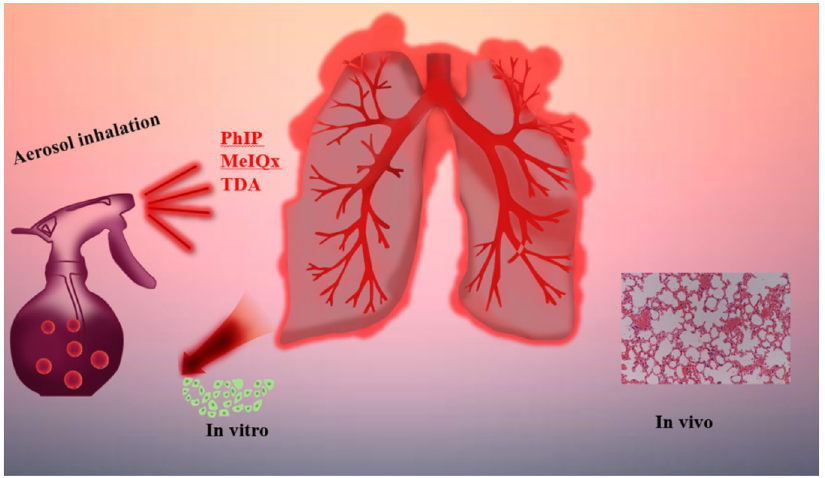
Figure 1. Schematic illustration of the evaluation of PhIP, MeIQx and TDA aerosols exposure on the HepG-2, L02, HelF and A549 cells in vitro and on the mice in